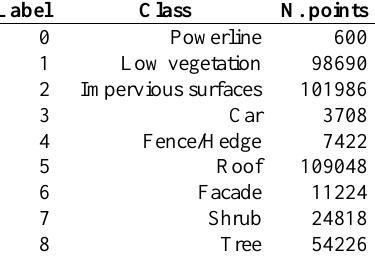
Table 1. Number of points per class.